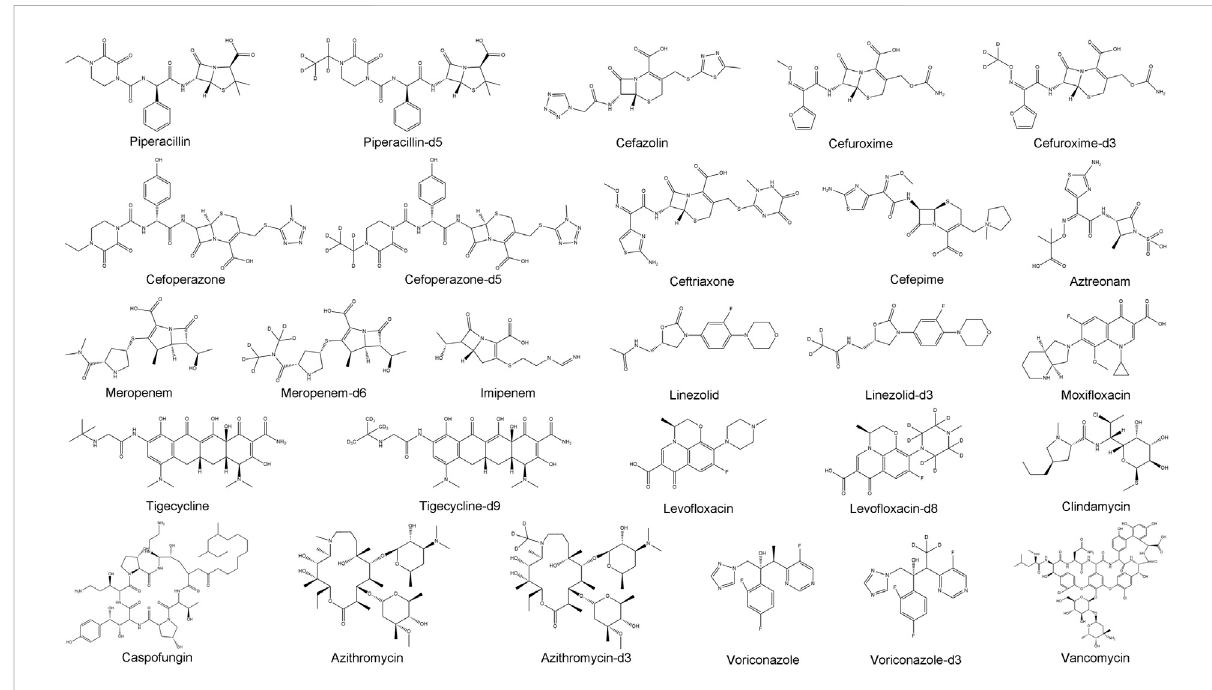
FIGURE 1 Chemical structures of 18 antimicrobial agents and nine internal